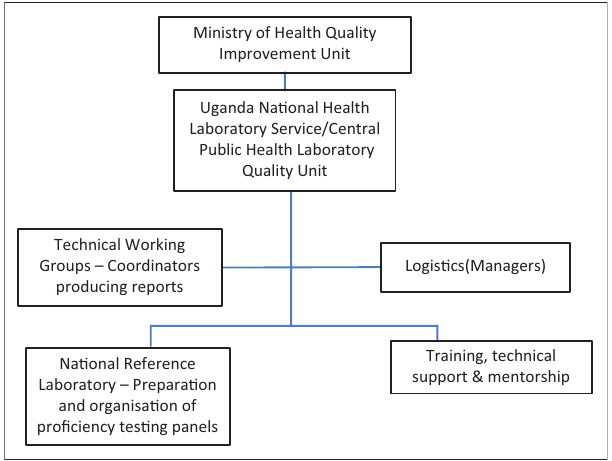
FIGURE 3: Proposed national external quality assessment coordination structure.